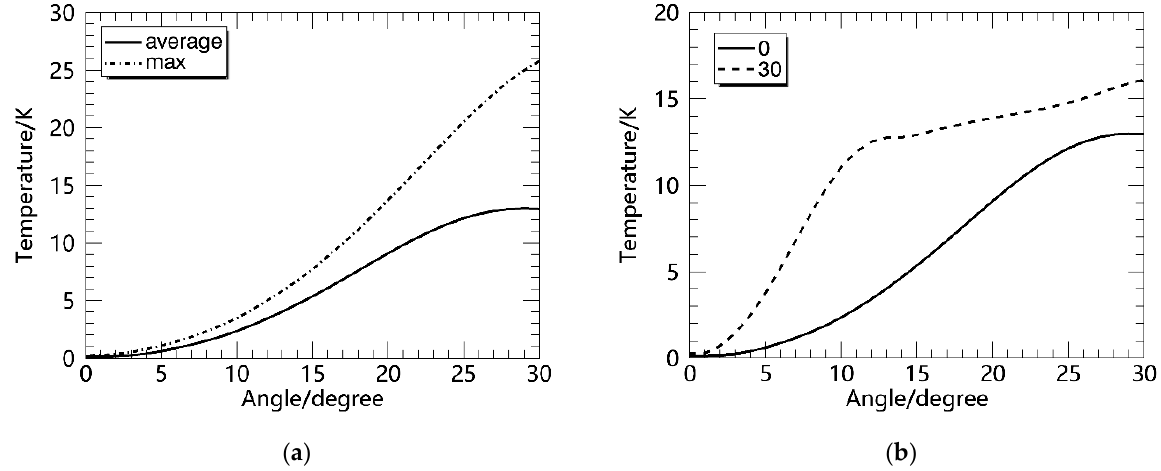
Figure 10. (a) The average (solid line) and max (dash-and-dot line) deviations in temperature vary from 0° to 30° at θ 0 =0°; (b) the average deviations in temperature vary from 0° to 30° at θ 0 =0° (solid from 0 ◦ to 30 ◦ at θ 0 = 0 ◦ ; ( b ) the average deviations in temperature vary from 0 ◦ to 30 ◦ at θ 0 = 0 ◦ line) and θ 0 =30° (dashed line). (solid line) and θ 0 = 30 ◦ (dashed